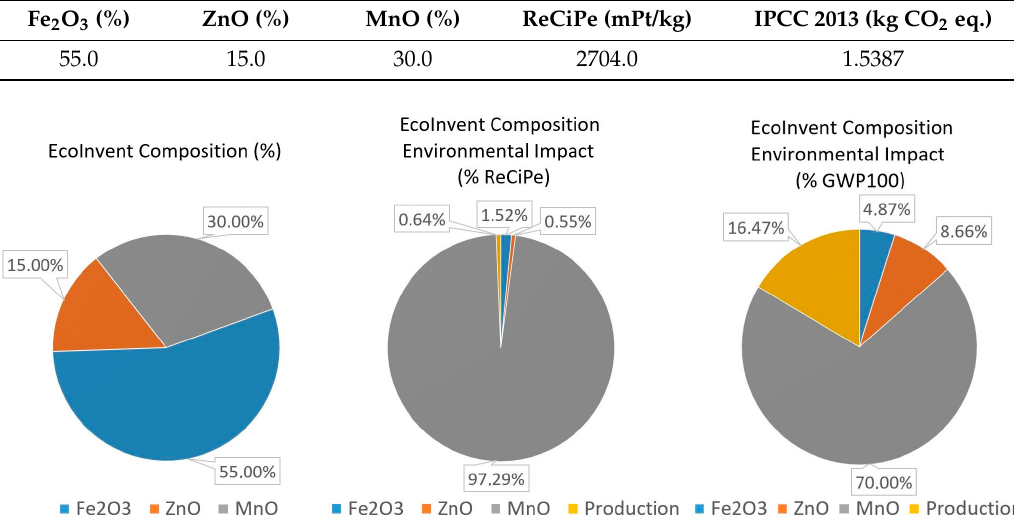
Table 12. EcoInvent ferrite dataset environmental impact in the ReCiPe and Carbon Footprint methodology.